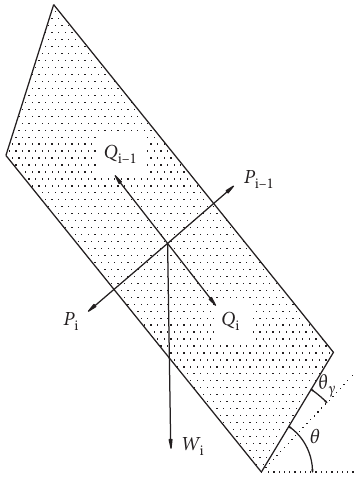
Figure 4: Force analysis chart of stratum i for shear